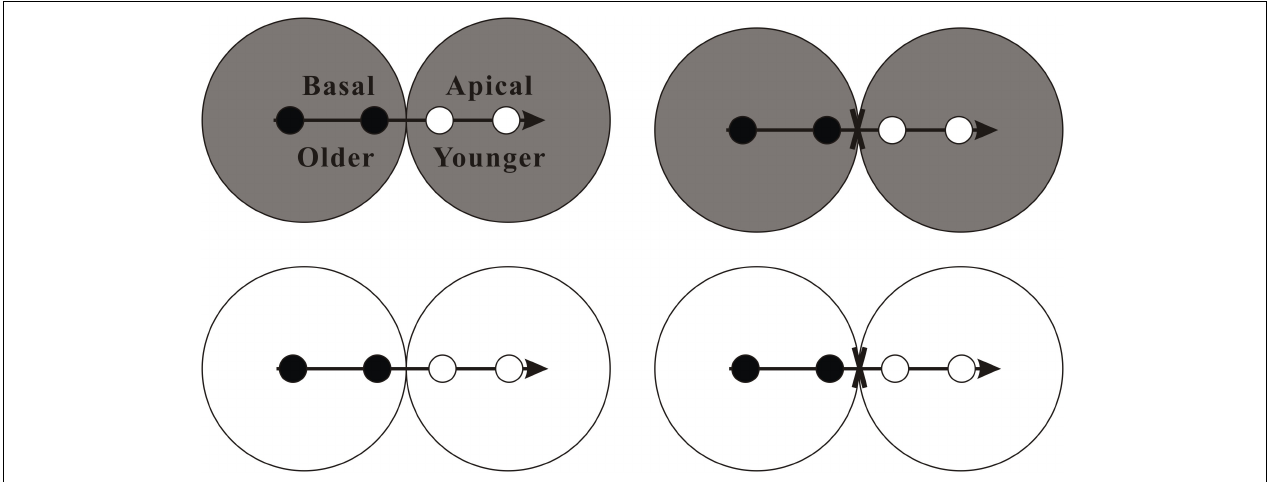
FIGURE 1 | Schematic representation of the experimental design. There were four experimental treatments involving stolon connection and soil nutrient availability. Clonal fragments of the invasive plant A. philoxeroides , each consisting of two basal ramets (black circles) and two apical ramets (white circles) with a stolon apex (horizontal arrow), were grown either under high soil nutrient availability (gray) or under low soil nutrient availability (white), and with the stolon connections between basal and apical ramets were either intact or severed (fork). See text for additional explanation.